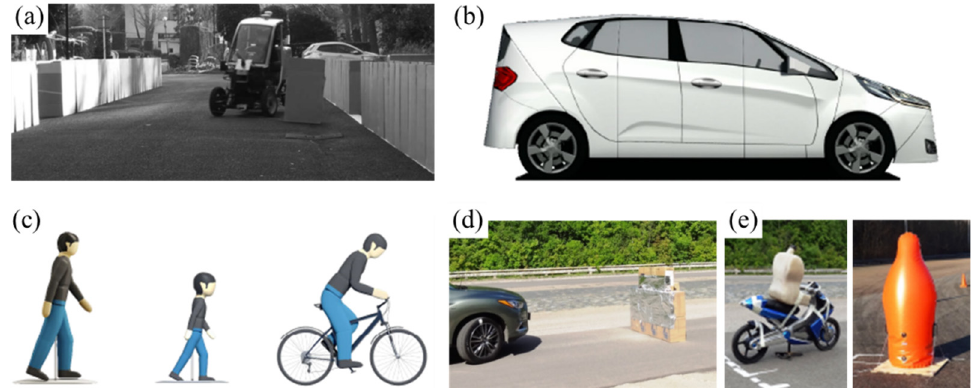
Figure 6. Obstacles examples used in experimental research scenarios: ( a ) pieces of cardboard to mark the road lane and the obstacle [34]; ( b ) soft car target on a moving platform [17,28]; ( c ) pedestrian, child, bicyclist dummy on a moving platform [43]; ( d ) soft wall covered with a metallized mirrored film [56]; ( e ) motorcyclist and human figure dummy [56].